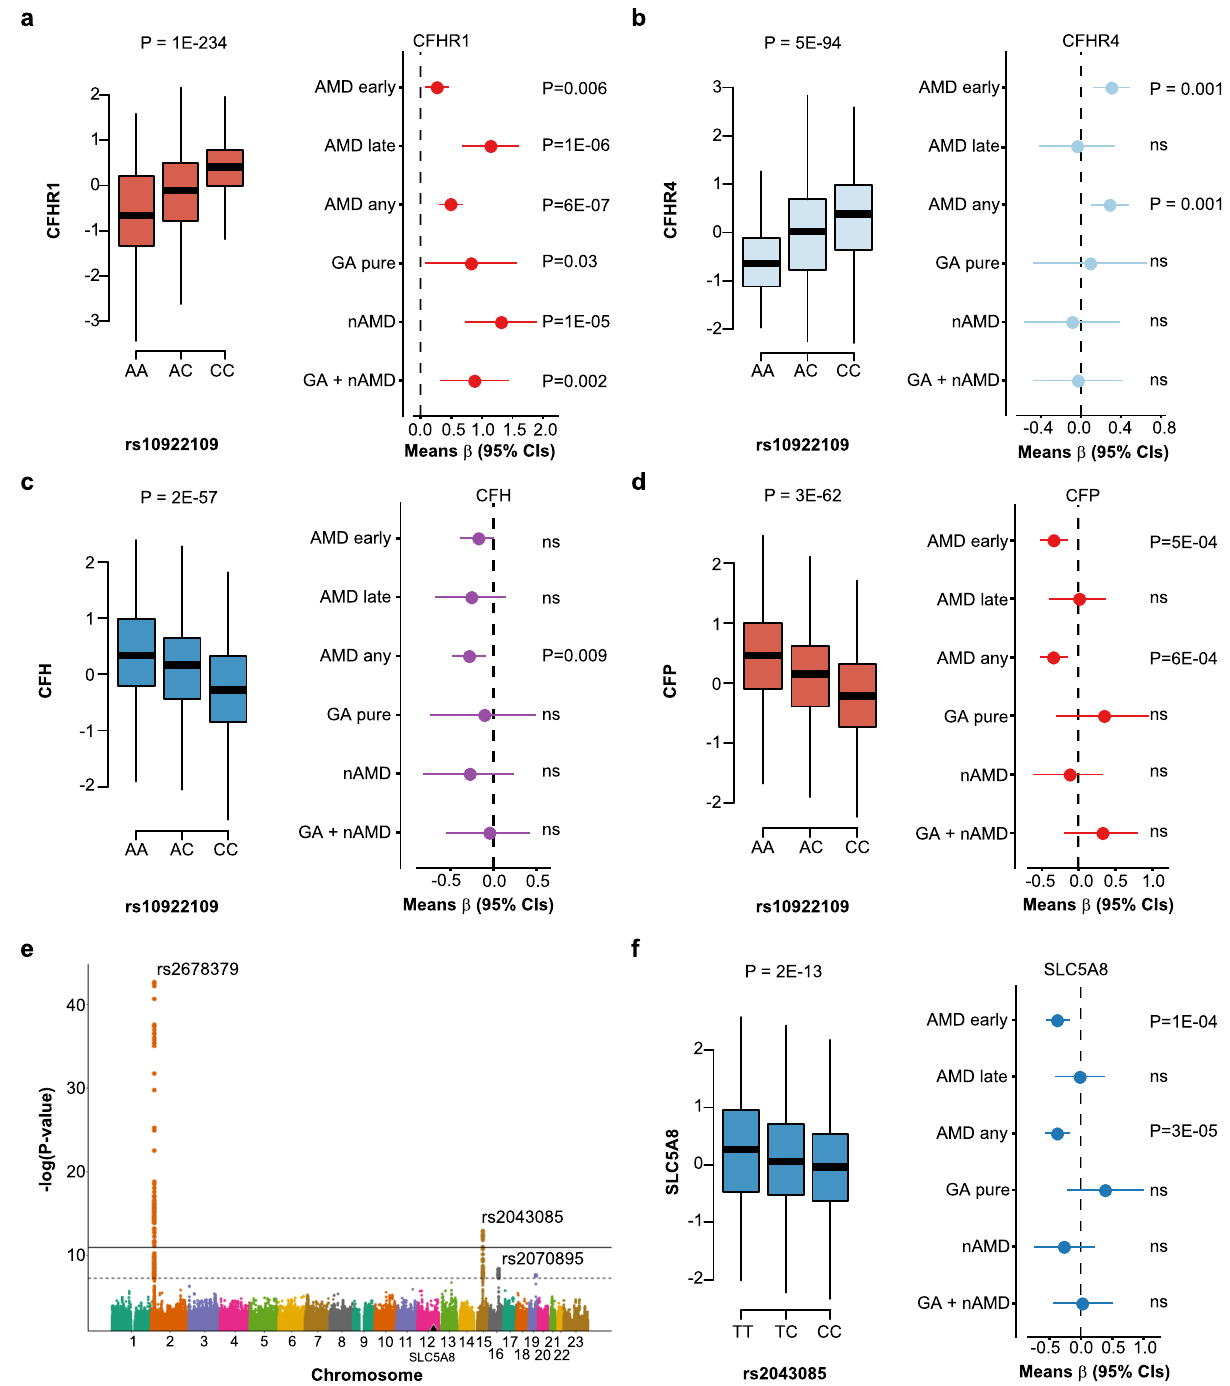
Fig. 6 Serum proteins linked to AMD risk variants and AMD-related outcomes. a Box plot showing serum levels of CFHR1 as a function of copy C alleles for the variant rs10922109 (left panel). The relationship between the 5th and 1st quintile (reference) of CFHR1 serum levels and various AMD related outcomes is shown in the right panel. b – d Similar plots for CFHR4, CFH and CFP. e The Manhattan plot highlights trans -acting variants at different chromosomes in a GWAS of serum SLC5A8 levels, speci fi cally the AMD-associated variants rs2070895 and rs2043085, as well as the variant rs2678379, which affects lipoprotein levels. The y -axis shows the − (log 10 ) of the P -values (two-sided) for the association of each genetic variant present along the x - axis at different chromosomes. f A box plot (left panel) of the AMD-associated variant rs2043085 affecting serum levels of SLC5A8 ( P = 2 × 10 − 13 , two- sided), and the relationship of the 5th and 1st (reference) quintiles of SLC5A8 levels with different AMD-related outcomes (right panel). All box plots in the fi gure show median (middle line), 25th, 75th percentile (box), and 5th and 95th percentile (whiskers). The relationship between SNPs and protein levels was studied using linear regression, while the protein relationship to AMD outcomes was examined using logistic regression. All regression analyses were age and sex adjusted. The data points in the right panels of a – d , f are the mean estimate of beta in the logistic regression (logOR) using quintiles as continuous predictor variable and the error bars represent 95% CIs. All highlighted P -values are two-sided. NS stands for not signi fi cant ( P > 0.05). The number of patients in each AMD-related group is shown in Supplementary Data 1 and described in Methods